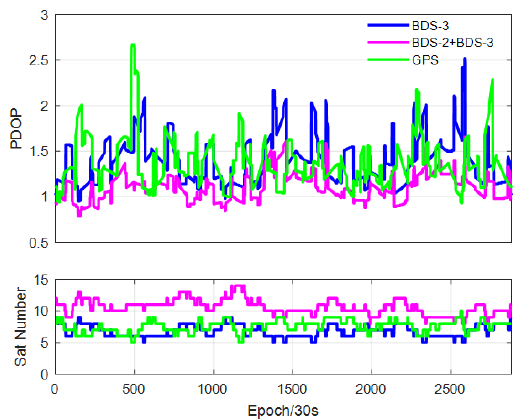
Figure 2. Number of available satellites and PDOP